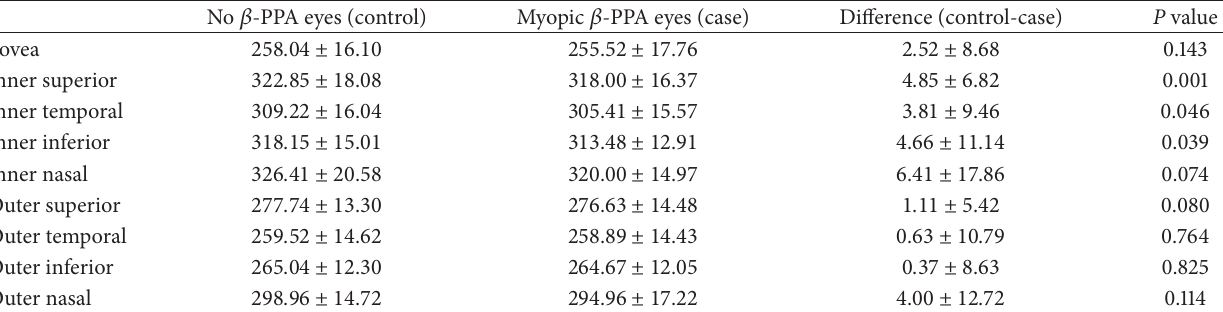
𝛽 -PPA, 𝛽 -zone parapapillary atrophy.